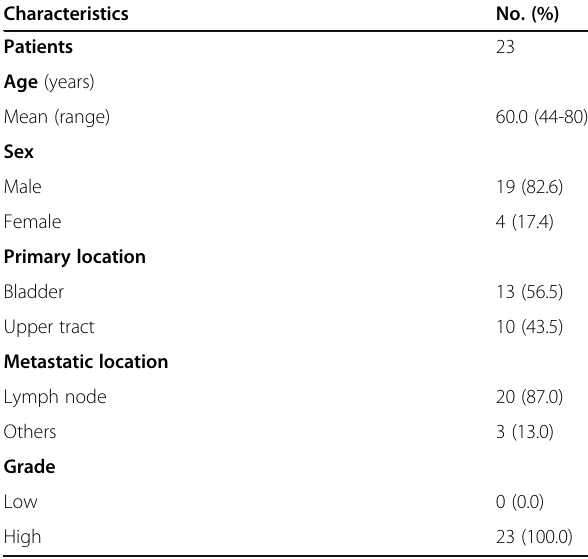
Table 2 Pathologic and clinical features of patients with metastatic UC